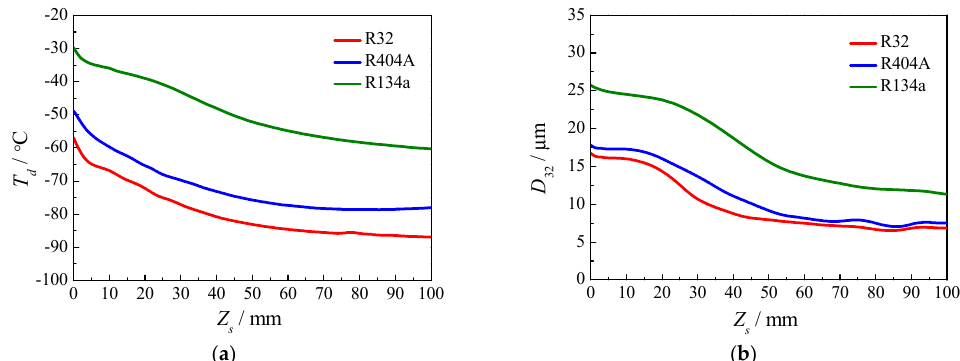
Figure 12. Comparison of the spray characteristics obtained using R134a, R404A and R32: ( a ) droplet temperature and ( b ) droplet Sauter mean diameter.